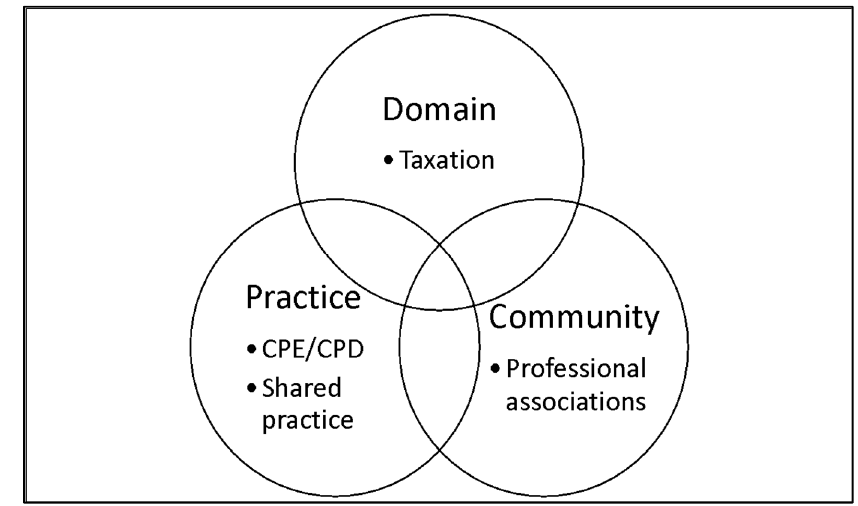
Figure 2. Community of practice in the taxation field.